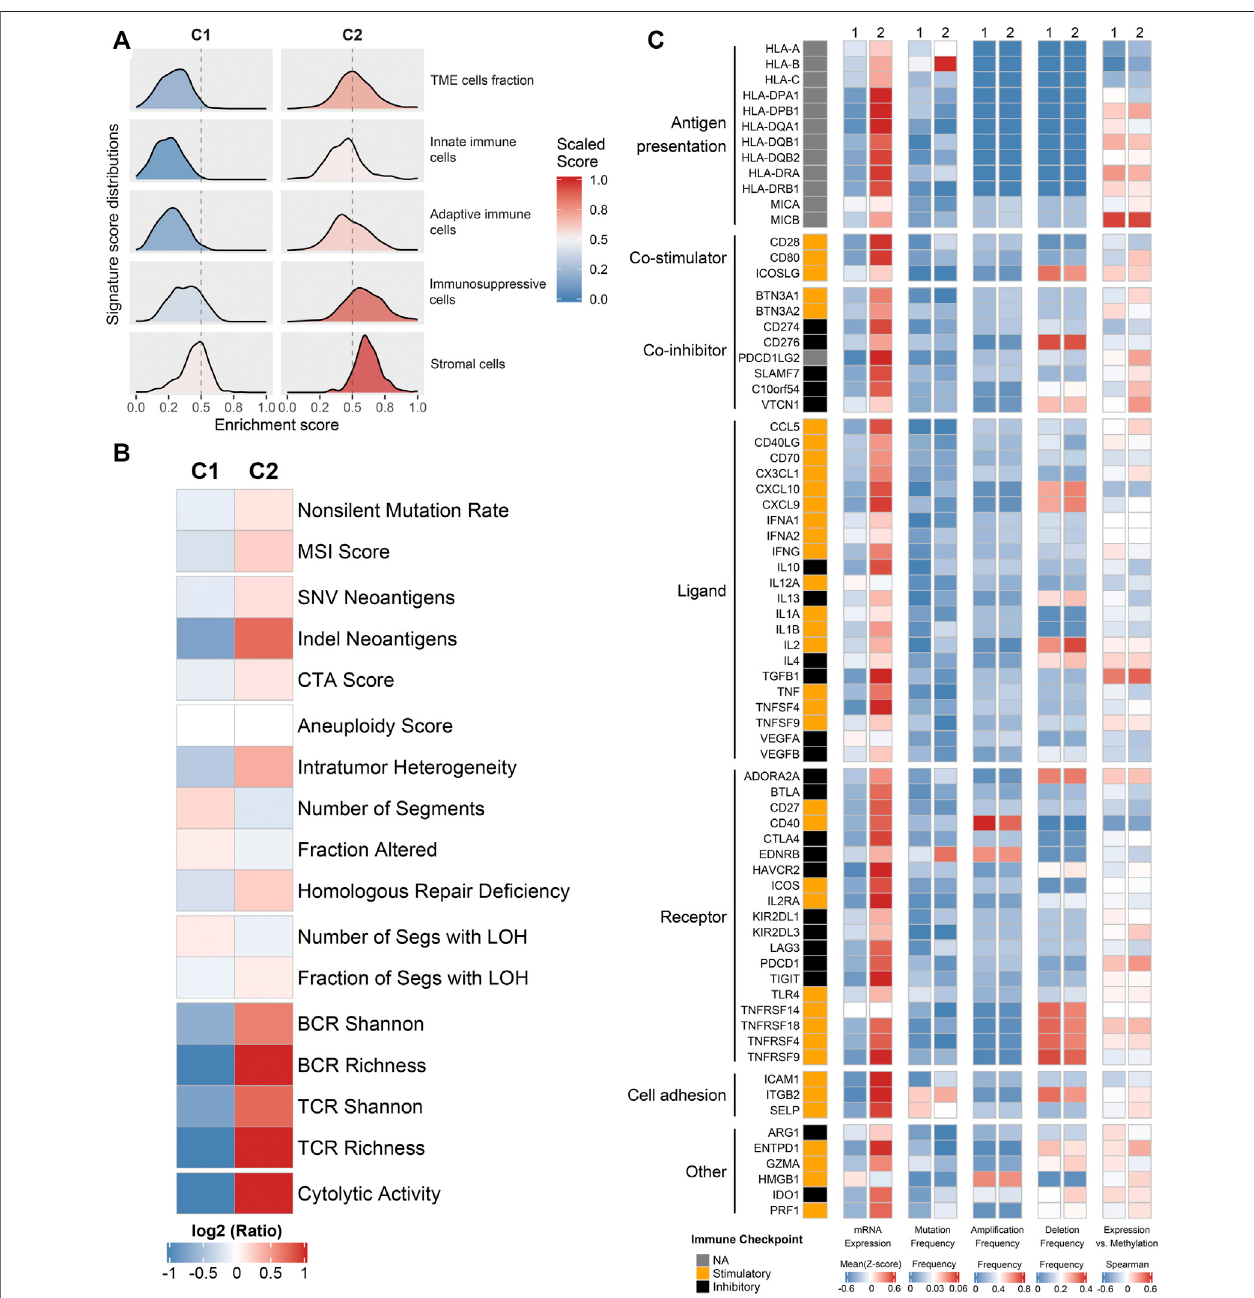
FIGURE 2 | Potential immune escape mechanisms of each phenotype. (A) The relative abundance distributions of two immune subtypes in TME cells fraction, innateimmunecells, adaptiveimmunecells,and stromalcells. (B) Theexpression levelsof17tumor immunogenicityindicatorsofinC1andC2. (C) Multi-omics analysis of 75 immunomodulators in two